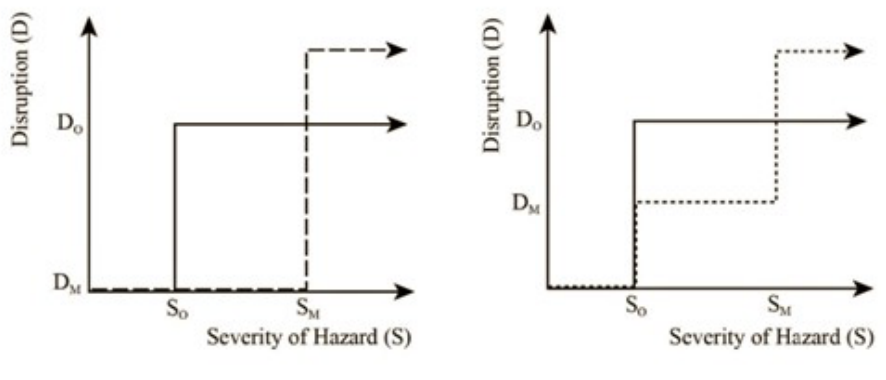
Fig. 4. Visualisation of the effect of